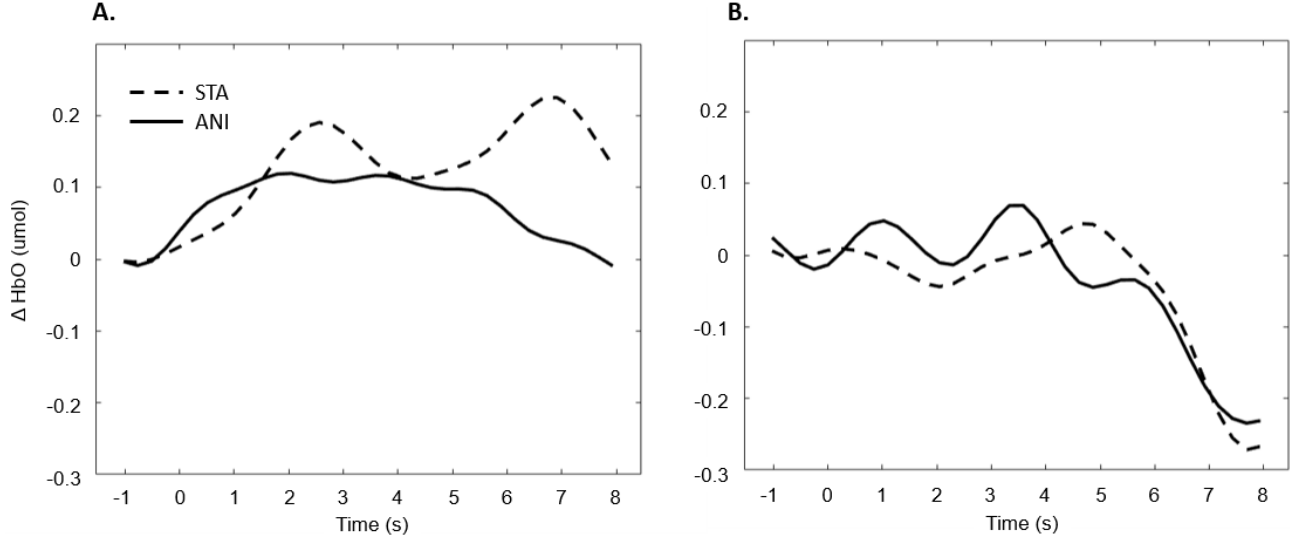
Figure 7. Average of the hemodynamic evoked response in the deaf group ( A ) and hearing group ( B ) for the two conditions in the frontal region.